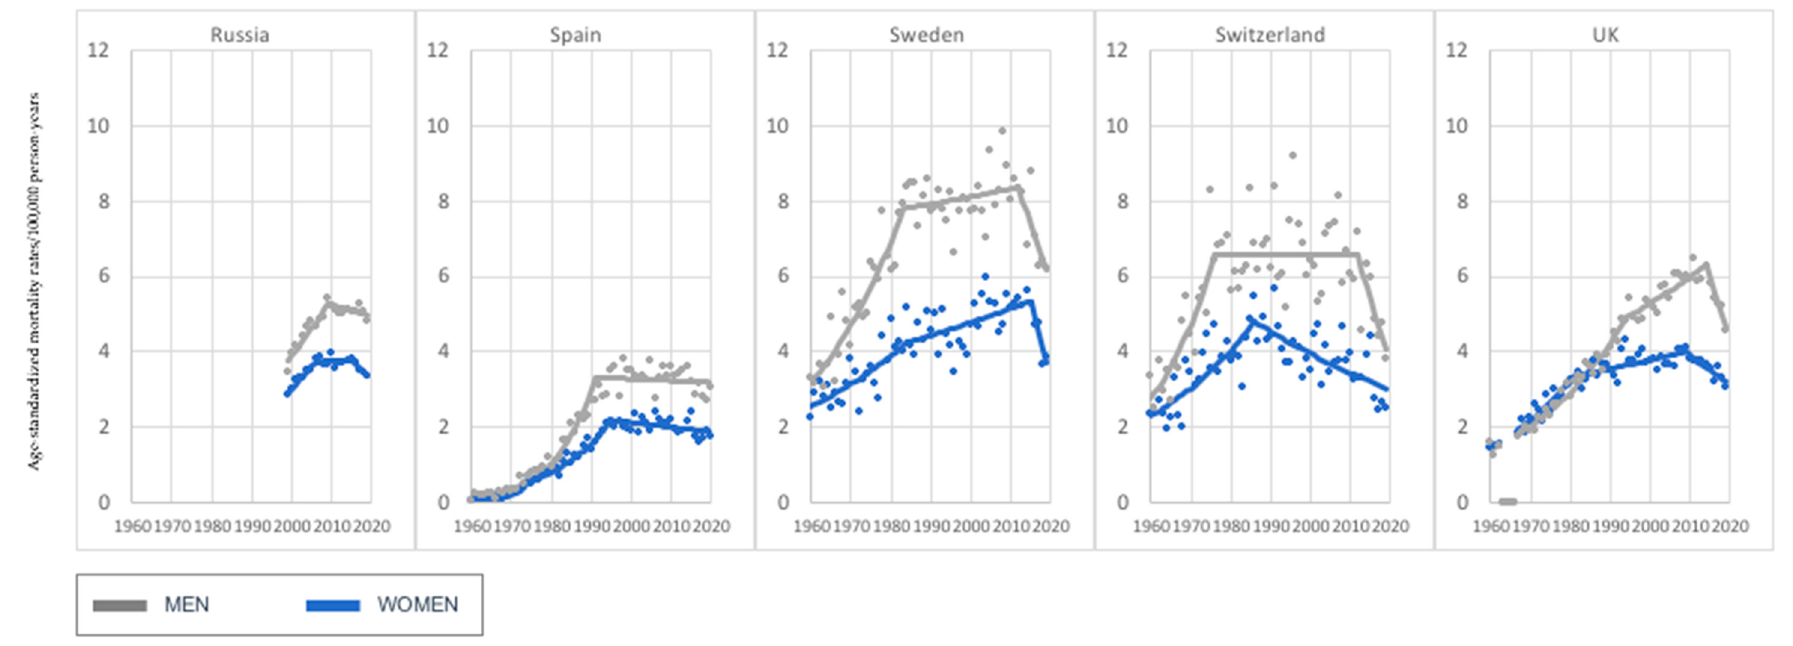
Figure 2. Melanoma mortality trends—15 countries with an investigated decrease in both sexes, age group 45–74 years old.